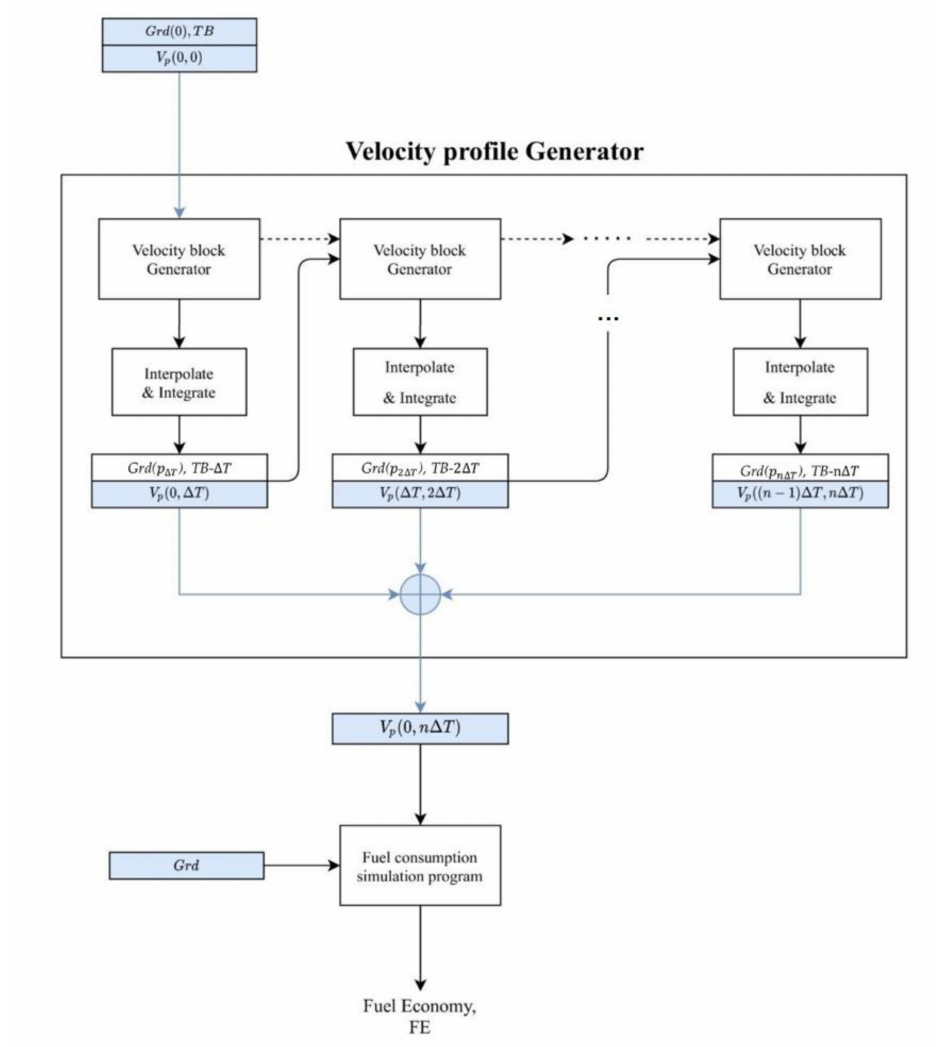
Figure 5. The velocity profile generator calls the velocity block generator multiple times until the trip is finished. The velocity block generator is made with DNN, and the dotted arrows represent hidden states of LSTM layers inside this neural network. It takes the state as input and outputs M values. These values are interpolated to be accelerations, which is integrated to be a velocity